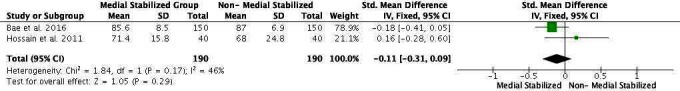
 Forest plot of final KSFS value of medial stabilized group and non-medial stabilized group (SD: Standard Deviation; CI: Confidence Interval).